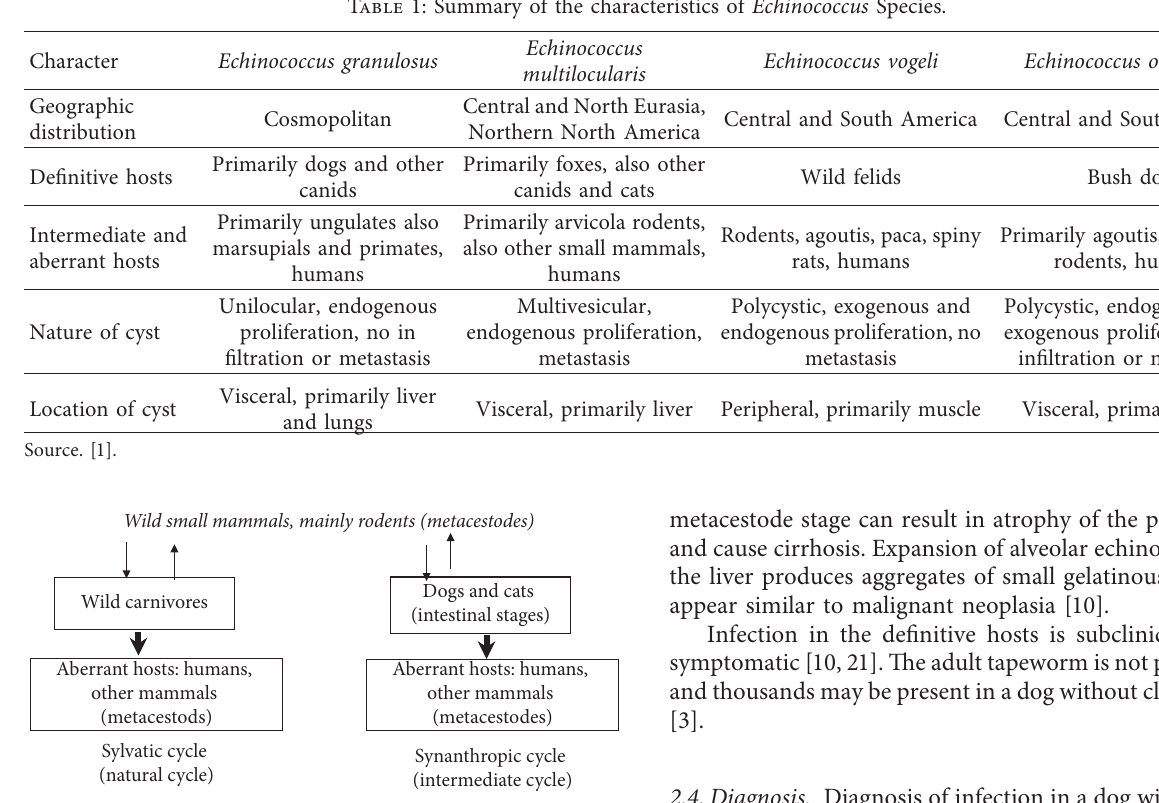
Figure 1: Epidemiologically relevant cycles of E. multilocularis (Source: